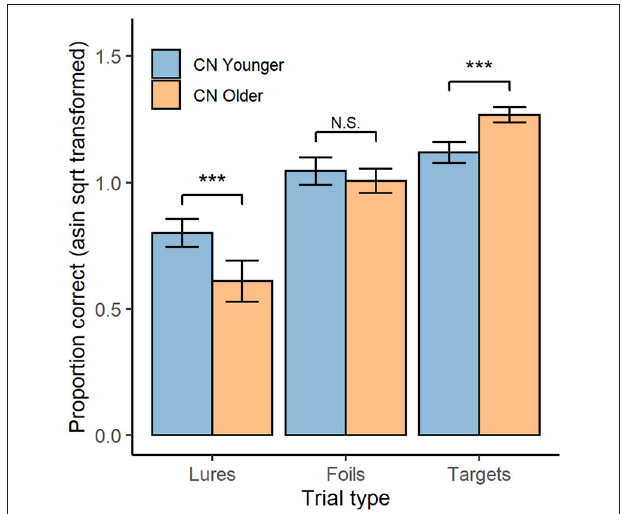
FIGURE 2 | OCL Performance by trial type and age group. Mean performance on both the OCL48 and OCL80 for each trial type (lures, foils, and targets; x-axis), for both younger (blue) and older (orange) groups. Error bars represent 95% confidence intervals. Asin sqrt, arcsine square root N.S., non-significant. *** p <